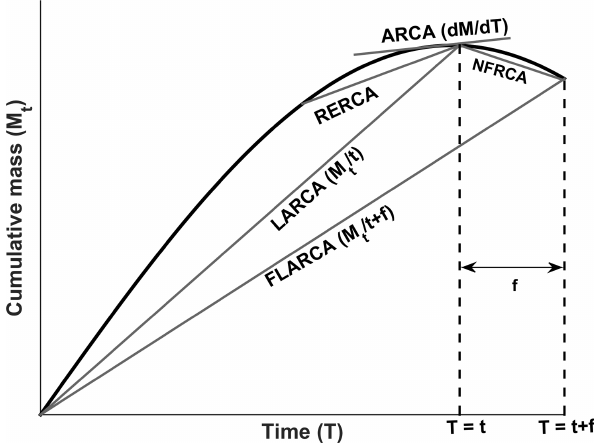
Figure 2. Commonly used measures of peat accumulation rate: long-term (apparent) rate of C accumulation (LARCA), recent rate of C accumulation (RERCA), actual (true) rate of C accumulation (ARCA), simulated future long-term (apparent) rate of C accumu- lation (FLARCA) and near future rate of C accumulation (NFRCA; adapted from Rydin and Jeglum, 2013).